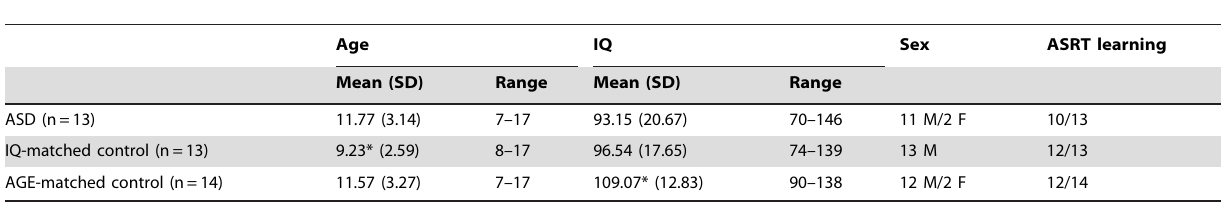
Table 1. General data of